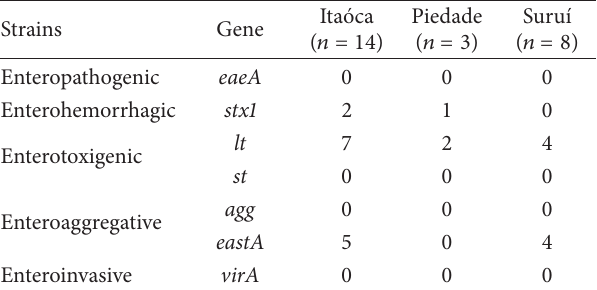
Table 3: Expression of E. coli virulence genes by PCR distributed by